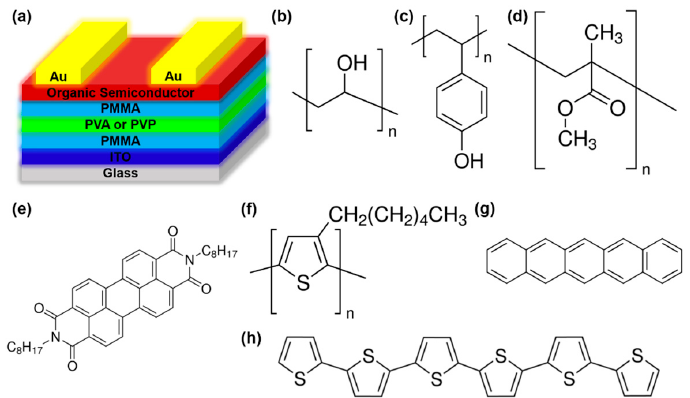
Figure 1. ( a ) Schematic structure of OFET with polymer trilayer dielectric, along with molecular structures of ( b ) PVA; ( c ) PVP; ( d ) PMMA; ( e ) PTCDI-C8; ( f ) P3HT; ( g ) pentacene; and ( h ) α -6T.